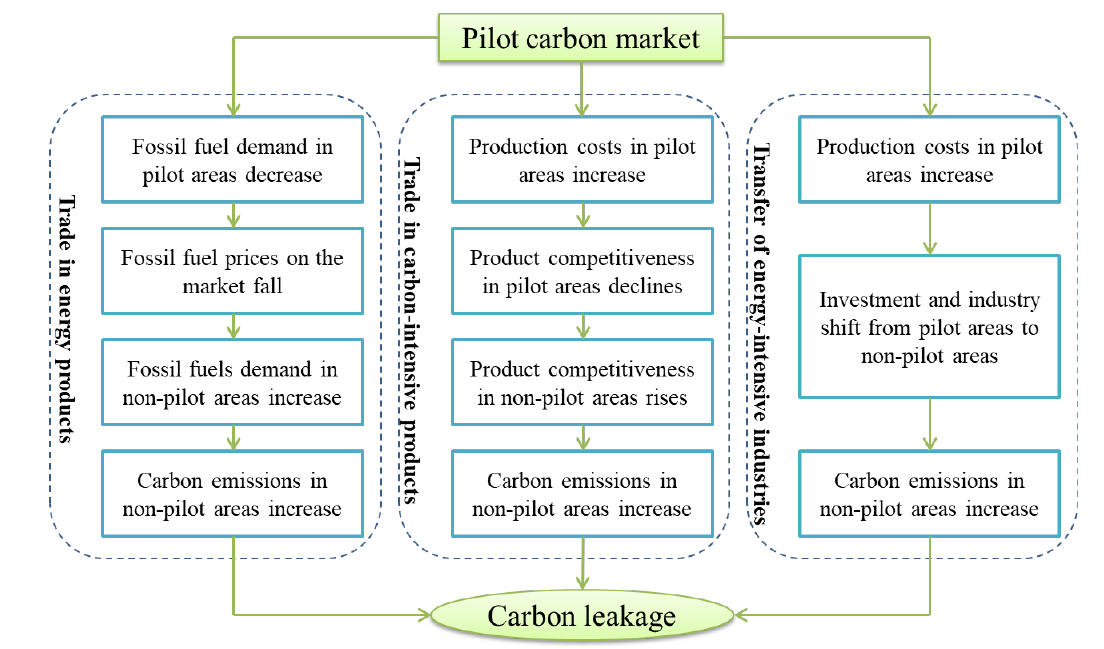
Figure 1. Theoretical mechanisms of carbon leakage.